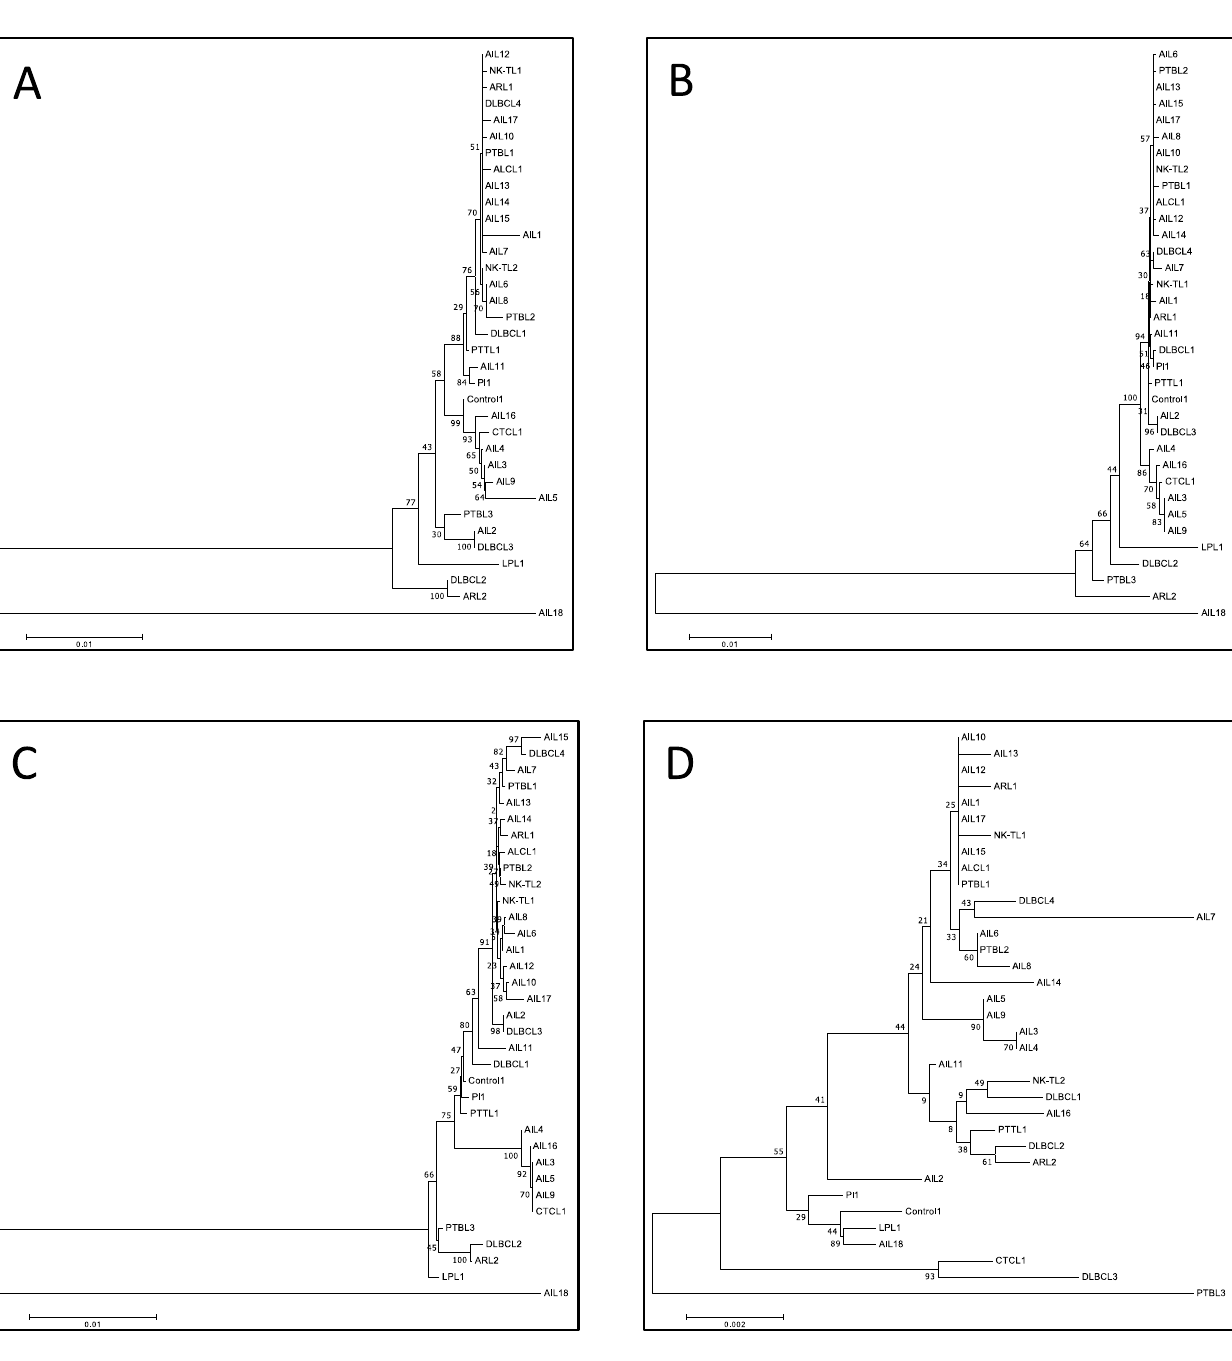
Figure 6. Phylogenetic tree obtained after nucleotide sequence alignment of the different strains. ( A ) EBNA-3A, ( B ) EBNA-3B, ( C ) EBNA-3C, ( D ) LMP-2. 3.6. Mutations Occurred Mostly in Latency Genes and Secondarily in Tegument Genes The means of the single nucleotide variations (SNVs) and the insertions and deletions (INDELs) were not higher in the AITL group compared to other lymphomas (respectively, 265 and 402 for SNVs and 5 and 7 for INDELs). The analysis of non-synonymous mutations according to nine main gene categories (namely latency, replication, membrane glycopro- tein, tegument, capsid, transcription, metabolism, packaging, and unknown function) showed that the majority of changes were located in latency genes, though a large number of mutations also occurred in tegument genes ( Figure 7). Conversely, capsid and transcrip- tion genes had the lowest number of variations. For each gene, we calculated the average number of non-synonymous mutations for the “AITL” group versus the “other lymphoma”